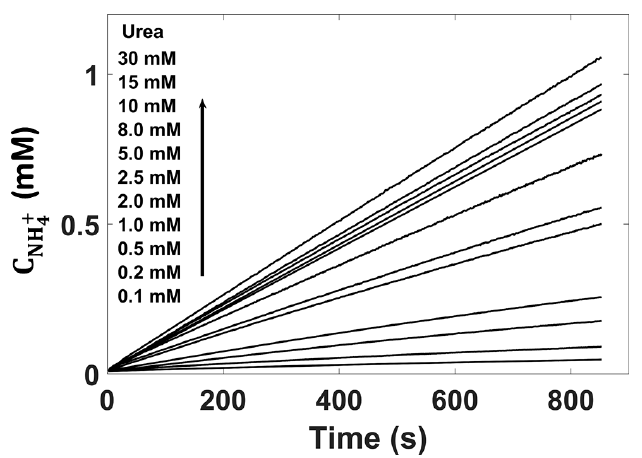
Figure 6. Kinetics of urea decomposition at constant urease activity (500 U/L) and different initial concentrations of urea (0.1 − 30 mM).